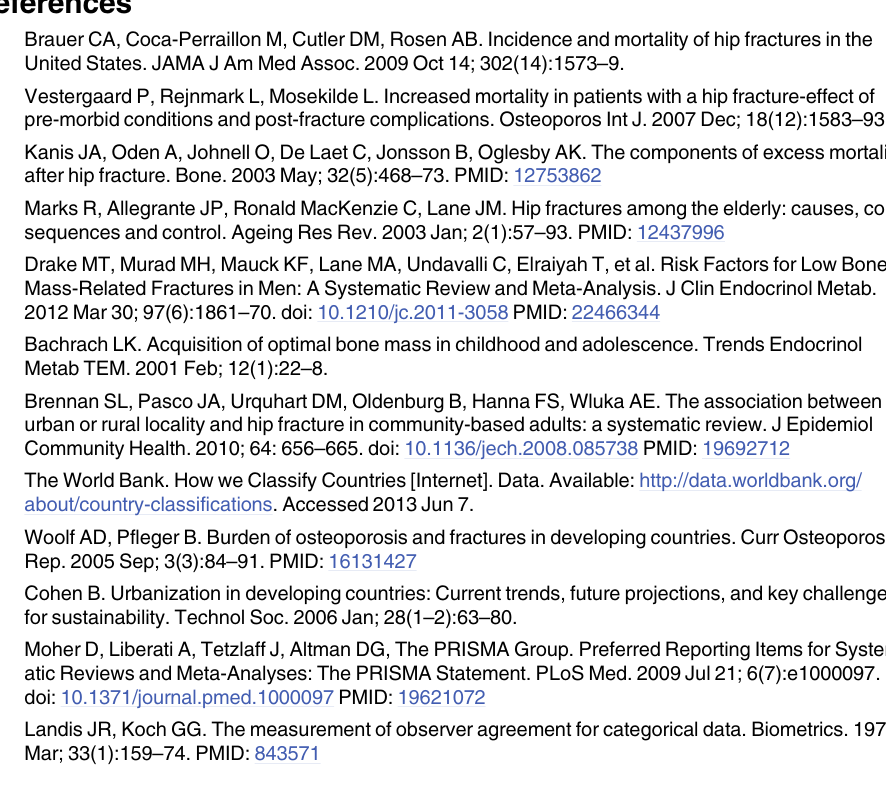
S1 Table. Summary of search